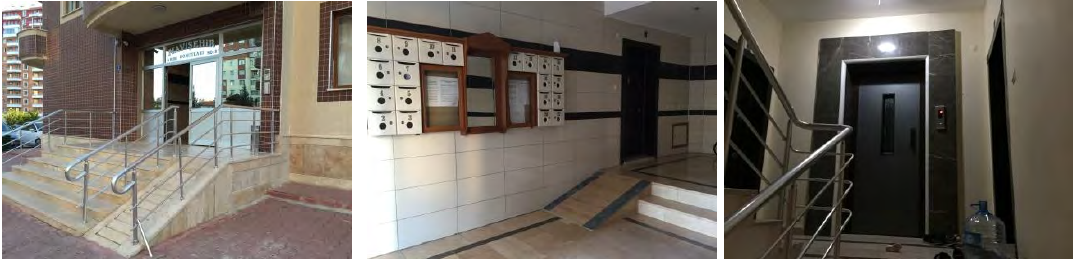
Figure 4: The entrance of the buildings (left) and circulation routes (middle and